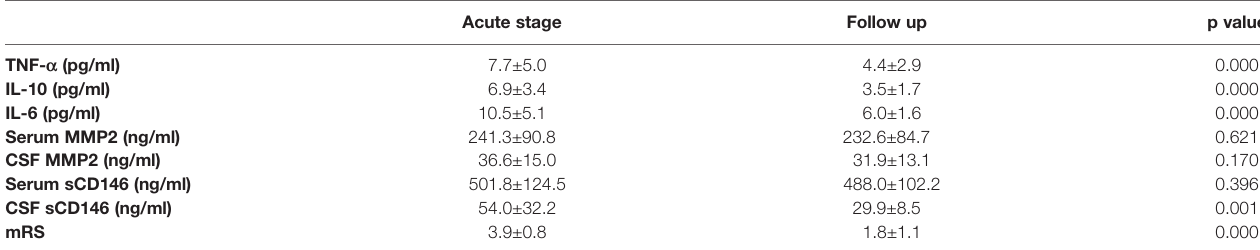
TABLE 2 | Expression of in fl ammatory factors in the CSF and serum of anti-NMDAR encephalitis patients at the acute stage and 3-month follow up.